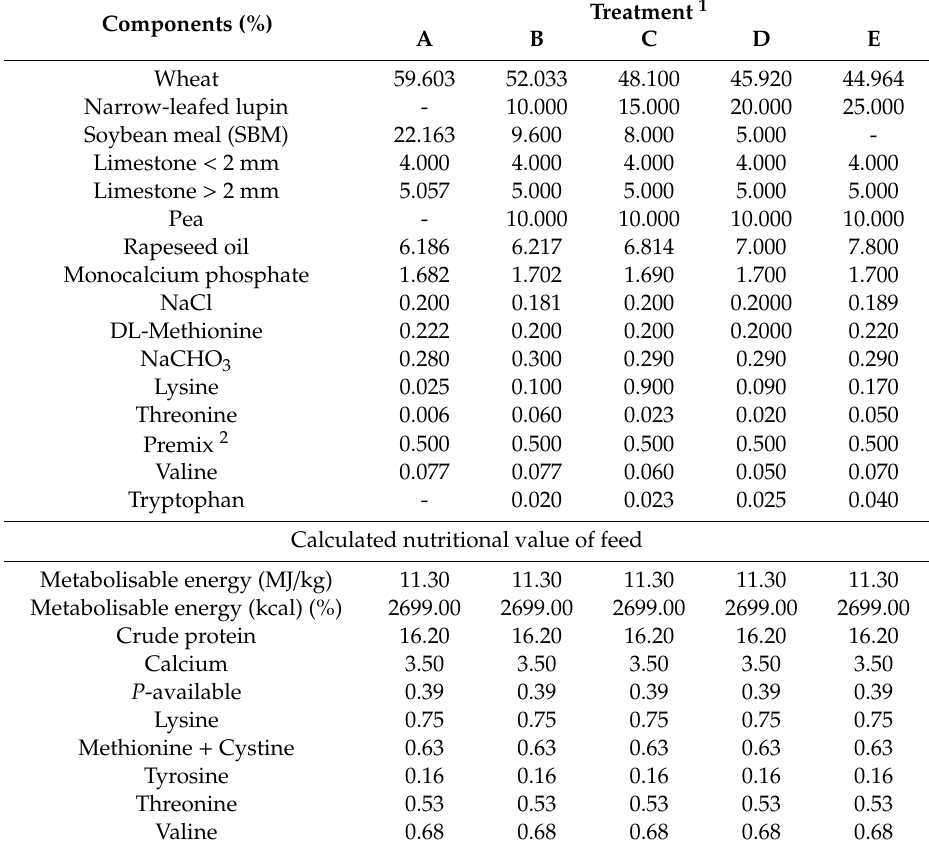
Table 1. Composition and nutritional value of feeds for laying